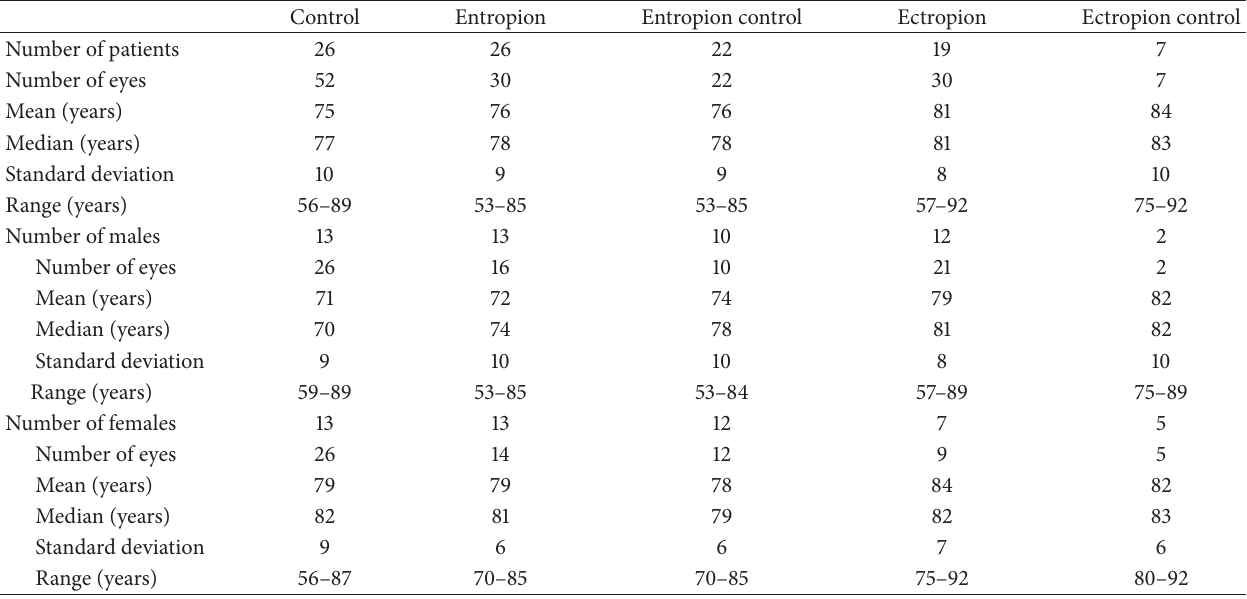
Table 1: Descriptive statistics for the age-matched control group, entropion group, entropion control group, ectropion group, and ectropion control